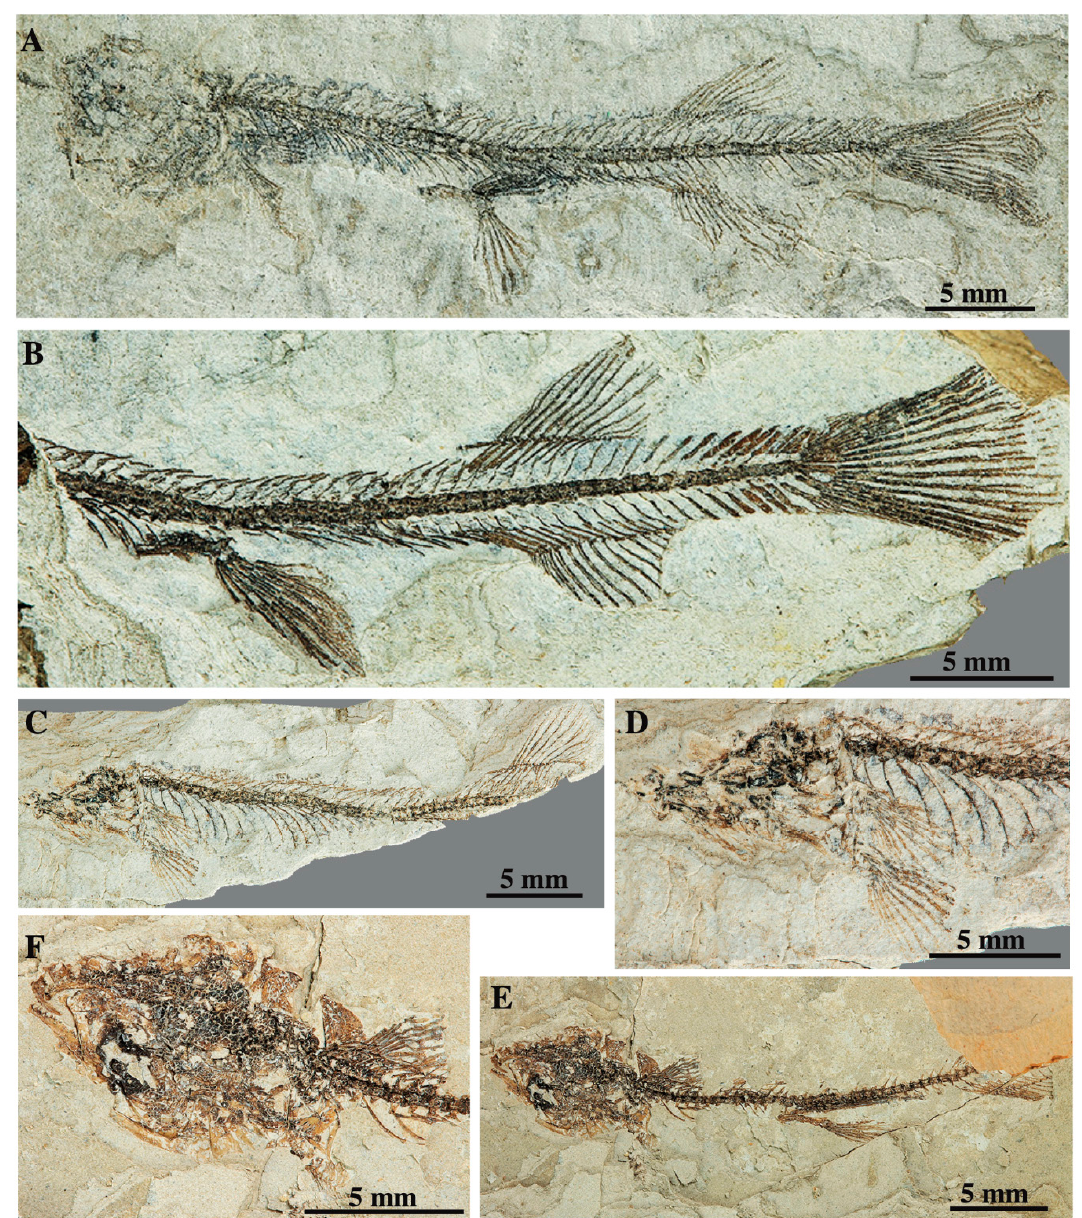
Figure 7. Kilmog Hill, middle Miocene. Galaxias n. sp. ‘Kilmog Hill’. A, Complete small adult (OU22481); B, Partial specimen showing fin morphology (OU22654); C, Partial adult (OU22658);